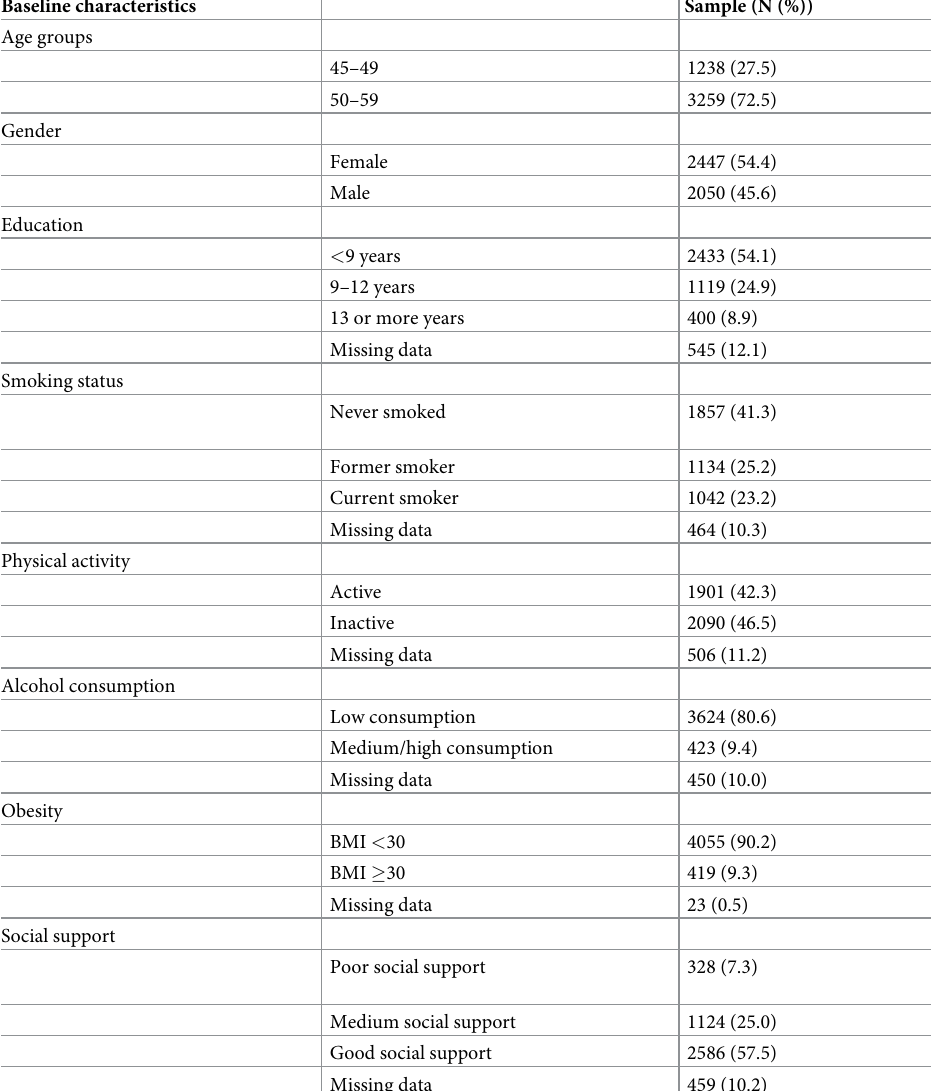
Table 1. Baseline characteristics of the study population in the HUNT1 study